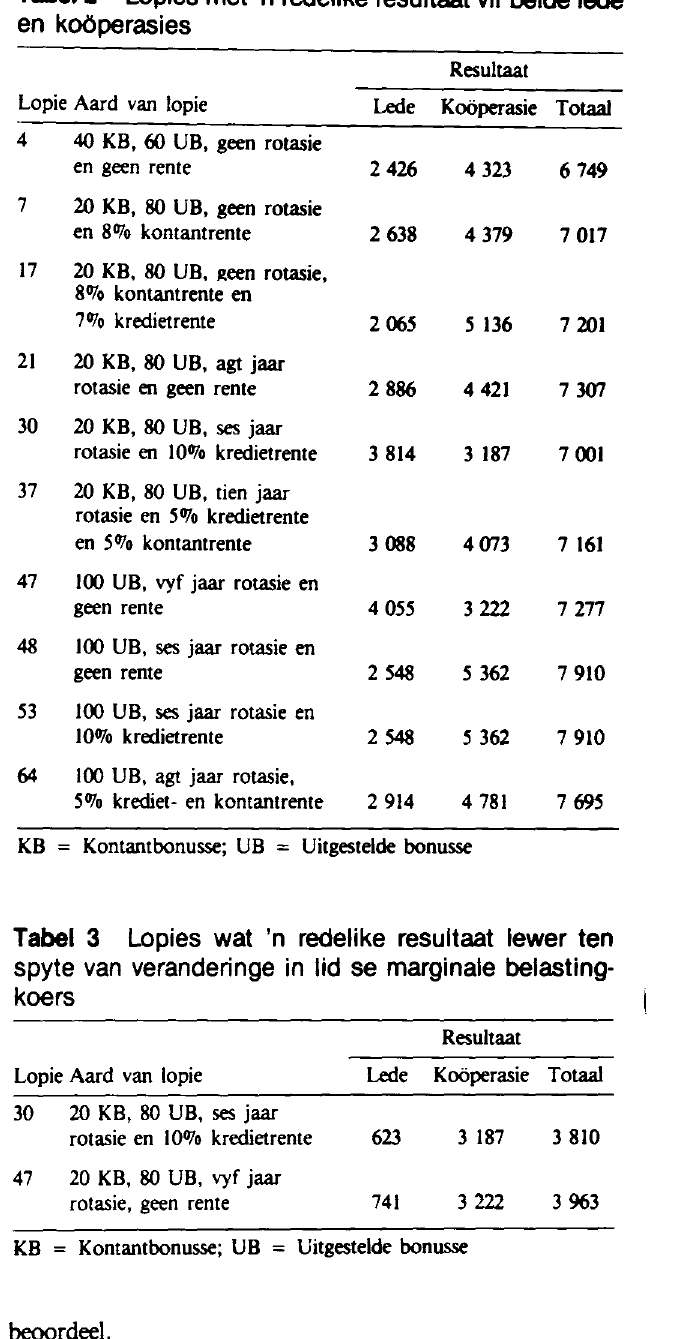
Lopies wat 'n redelike resultaat lewer ten spyte van veranderinge in lid se marginale belasting